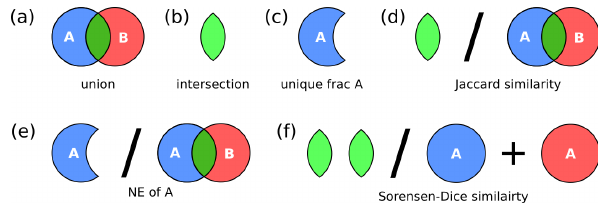
Figure 3. Hypervolume metrics utilized in this study: (a) union, (b) intersection, (c) unique fraction A, (d) Jaccard similarity metric, (e) niche expansion, and (f) Sørensen–Dice